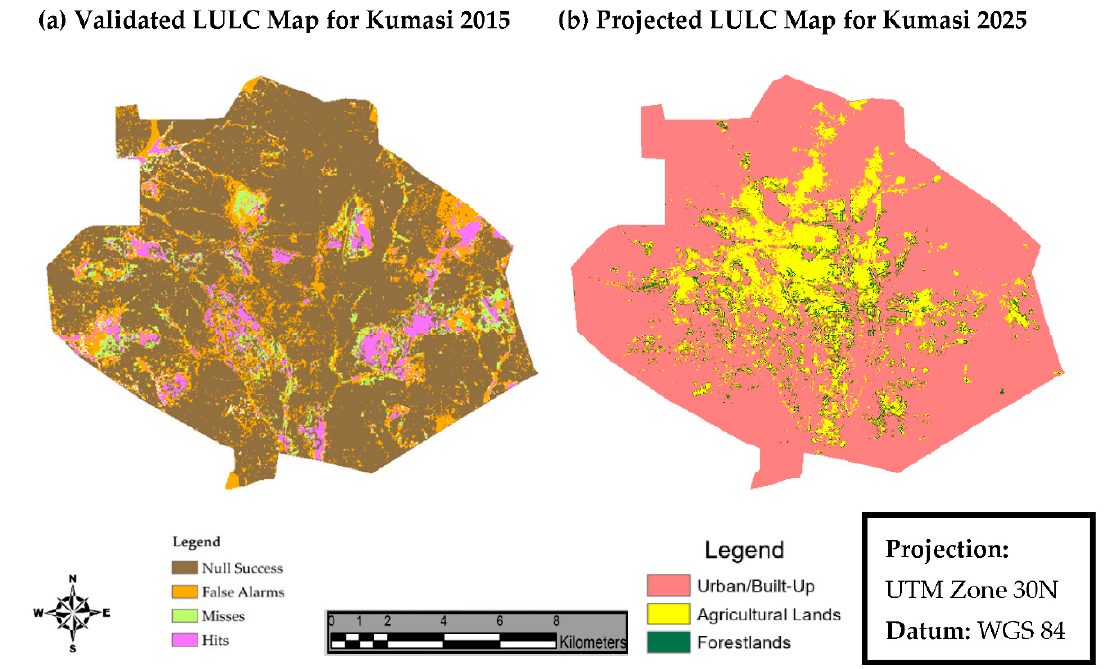
Figure 5. Validated and Projected maps.